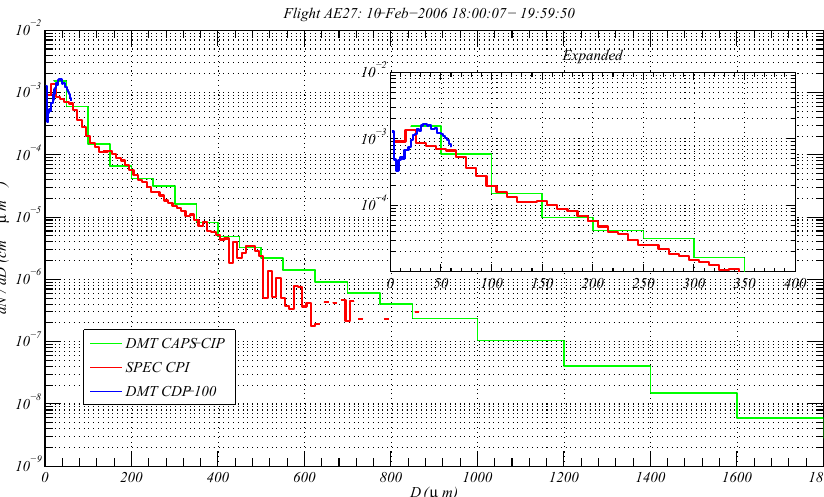
Fig. 3. Particle size distribution measurement comparison observed between the DMT CAPS- CIP; the SPEC CPI and the DMT CDP (2 < D < 62µm) instruments for particle size range 0 < D < 1800µm and 0 < D < 400µm (expanded plot). All probes show reasonable agreement; however, the CPI is limited by poor counting statistics at the larger particle sizes (as can be seen in the